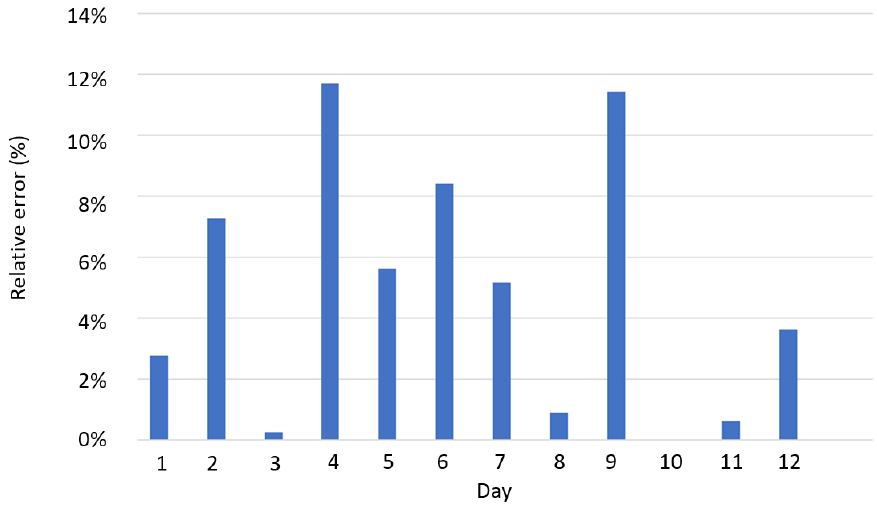
Figure 18. Communication relative errors: Average daily